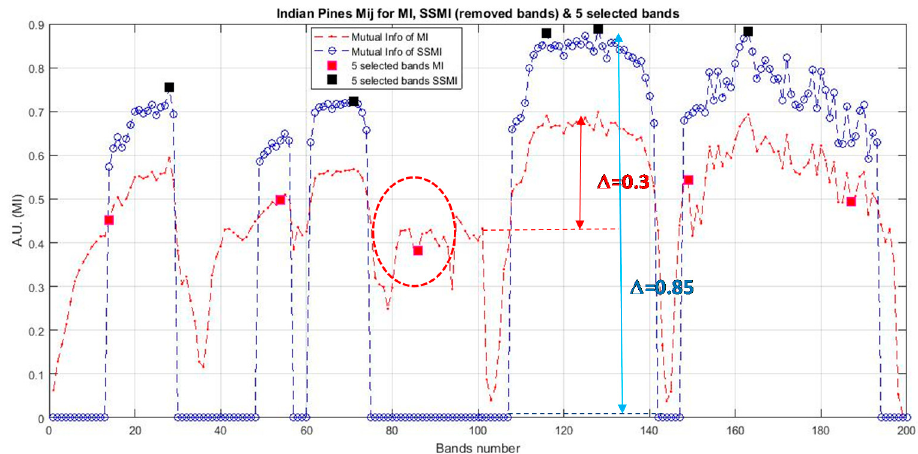
Figure 6. Depicts the I(A, B) of the bands of the Indian Pines dataset given by the MI (red plot) and SSMI (blue plot) BS methods. Note that the SSMI that utilizes both spatial and spectral information enhances the contrast of the I(A, B) by as much as approximately 200% in comparison to the basic MI BS without spatial